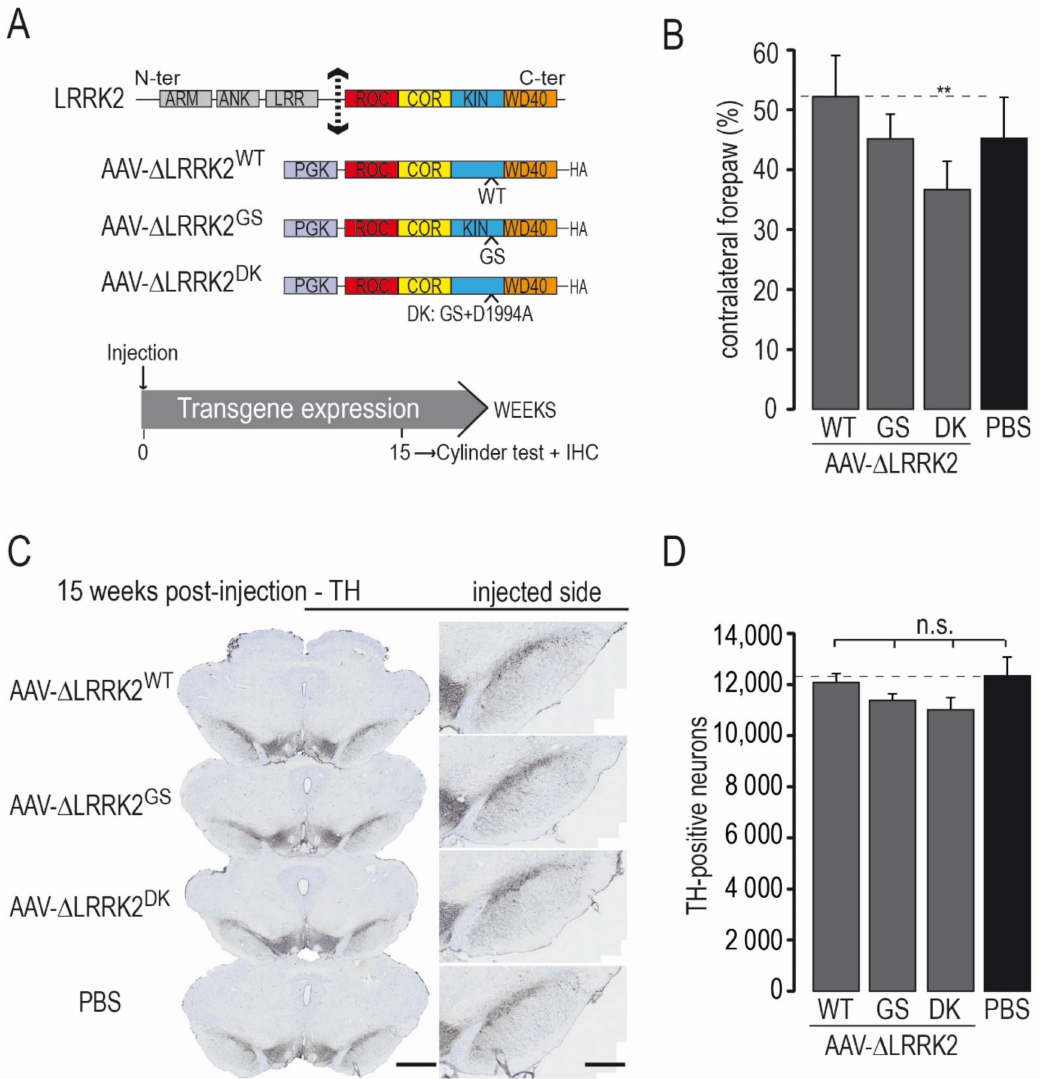
Figure 1. Effects produced by intra-nigral injection of AAVs coding for various forms of the C-terminal fragment of LRRK2. ( A ) Various forms of the C-terminal fragment of LRRK2 ( ∆ LRRK2) were cloned into an AAV backbone with the PGK promoter: the wild-type form (WT), the pathological form with the G2019S S substitution (GS), or the dead kinase form of G2019 with the D1994A mutation (DK). AAVs were unilaterally injected into the rat SNpc. The cylinder test, which assesses forepaw asymmetry use, was performed at 15 weeks post-injection (PI), and the rats were processed for histological evaluation (ICH). ( B ) Results of the cylinder test at 15 weeks PI. ( C ) Representative photomicrographs of sections of the various experimental groups labeled using Tyrosine Hydroxylase (TH) immunohistochemistry. ( D ) Number of TH-positive neurons in the SNpc measured using unbiased stereology. Results are expressed as the means ± the SEM. N = 8–12 animals/group. ANOVA and PLSD post hoc test. n.s.: not significant. ** p < 0.01. Scale bars: 750 µ m left panel and 400 µ m right panel in ( C